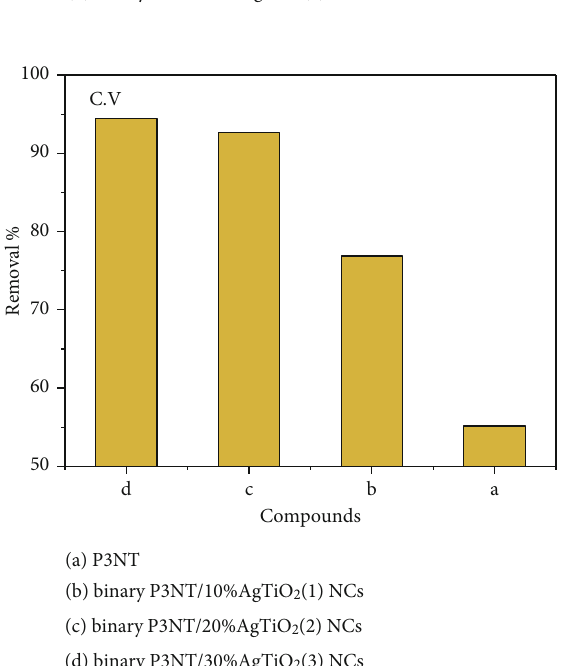
Figure 5: Removal e ffi ciency of P3NT (a), binary P3NT/ 10%AgTiO NCs (b), binary P3NT/20%AgTiO 2 binary P3NT/30%AgTiO NCs (d) of B.G. and C.V. 2